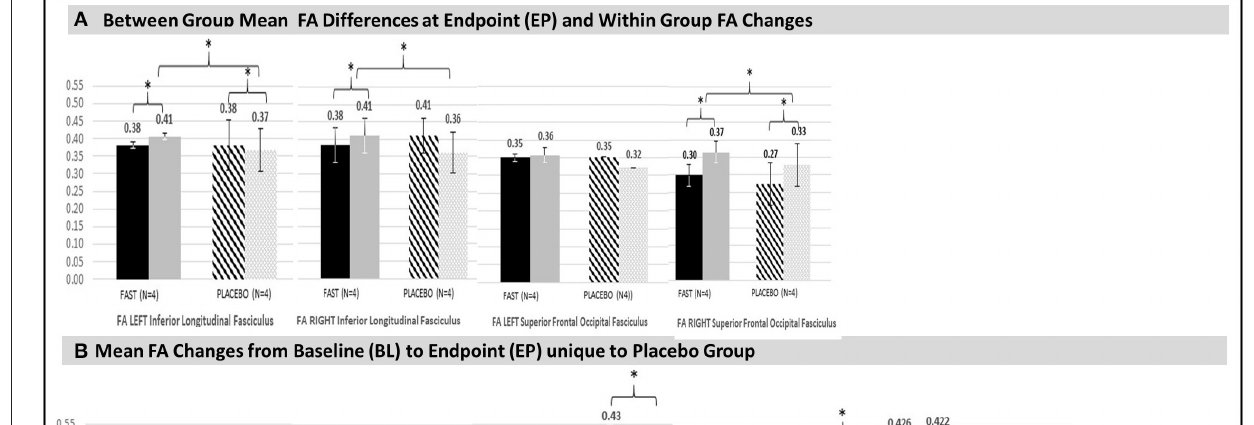
participant’s neurobehavioral gains exceed their measurement error defined as the conditional minimally detectable change (65) Figure 3 also indicates that the adjusted FA measures for the left ILF improved for the same three FAST participants (A, C, and D), but decreased for three of the four placebo participants. More specifically, these three FAST